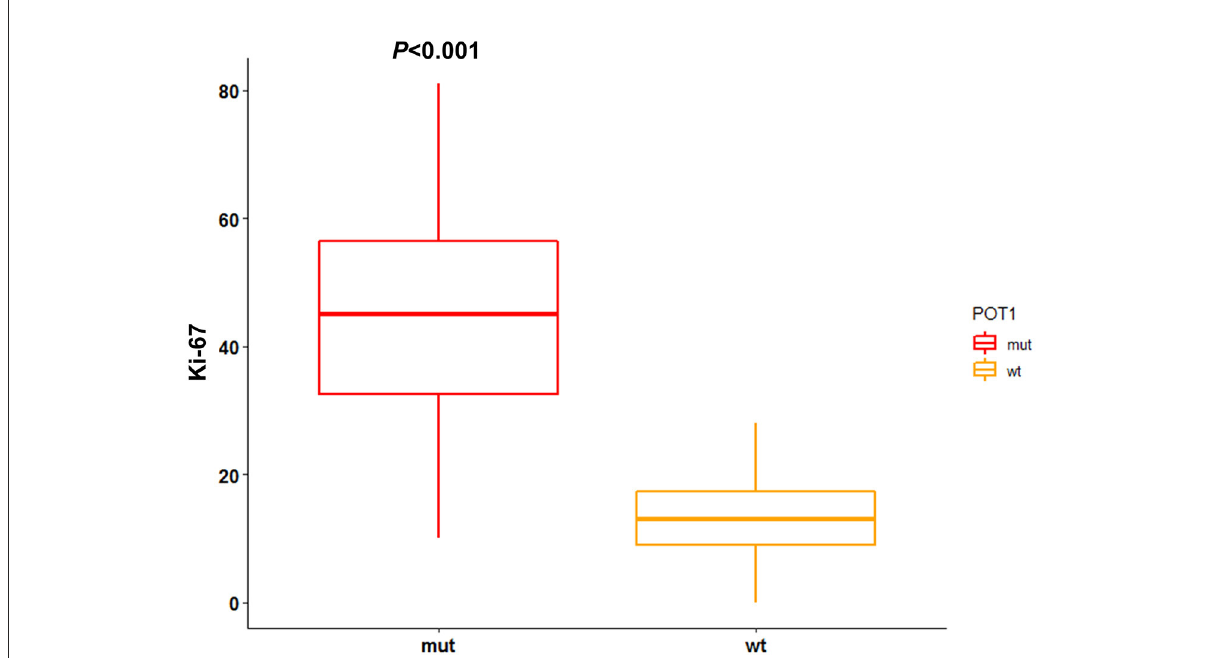
FIGURE3 Association between POT1 mutational status and Ki-67 index. IHC score for Ki-67 is reported as number of positive cells per 1,000 randomly selected cells excluding necrotic areas. The difference between median Ki-67 index among POT1 mutated and wild-type dogs was assesses through Mann-Whitney test (statistical significance set at P <